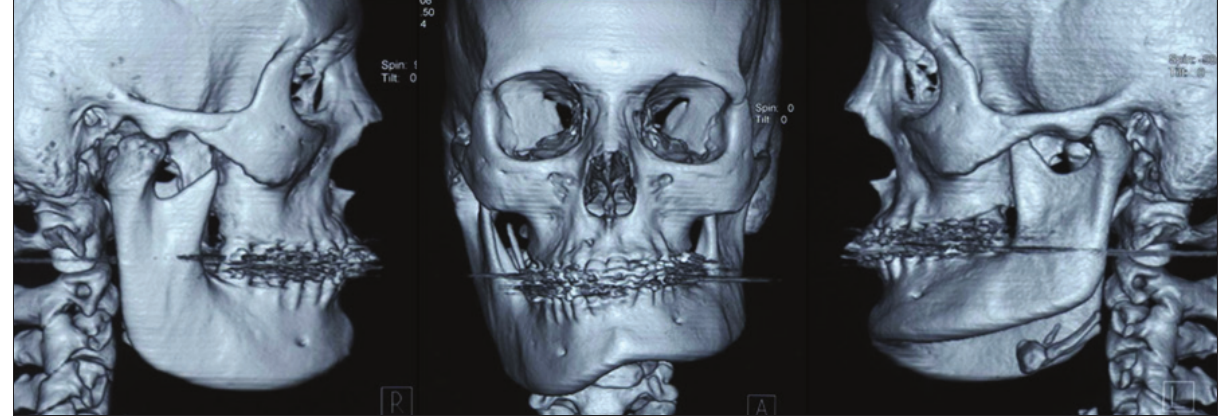
Figure 2a. Progress CT scan.